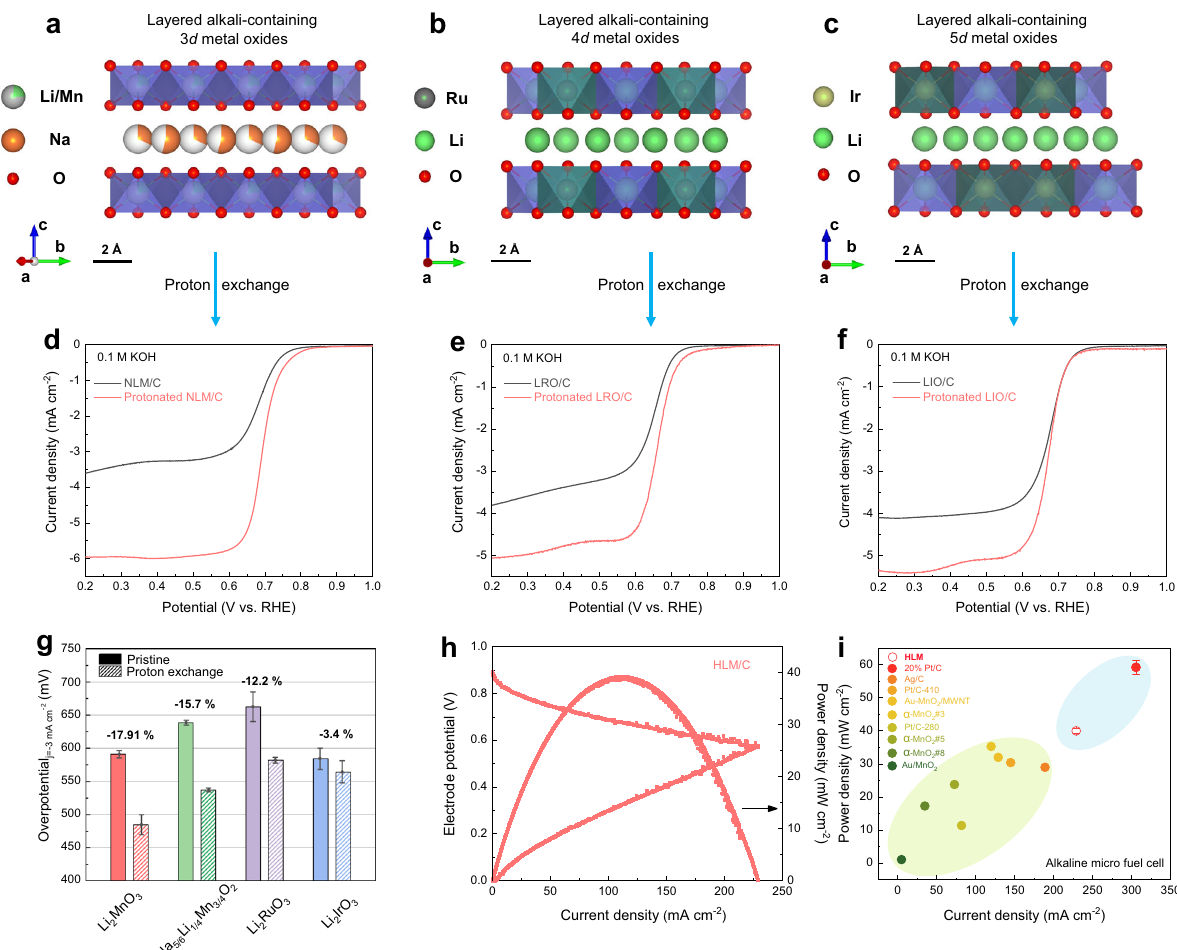
Fig. 6 Generality of concept and micro laminar fl ow fuel cell performance. Crystal structure con fi gurations of a layered Na-containing 3 d metal oxide, b layered Li-containing 4 d metal oxide and c layered Li-containing 5 d metal oxide. d – f ORR activity of layered alkali-containing (Li and Na) metal (from 3 d to 5 d ) oxides measured in 0.1 M KOH. g The overpotentials of Li 2 MnO 3 , Na 5/6 Li 1/4 Mn 3/4 O 2 , Li 2 RuO 3 , and Li 2 IrO 3 at a current density of − 3 mA cm − 2 before and after proton exchange. h Current-potential characteristics and corresponding power density curves of HLM in H 2 /O 2 - µ LFFCs. i Comparison of the HLM with other reported catalysts in alkaline-based micro fuel cells in terms of current density and power density. Error bars represent the standard deviation of at least three independent